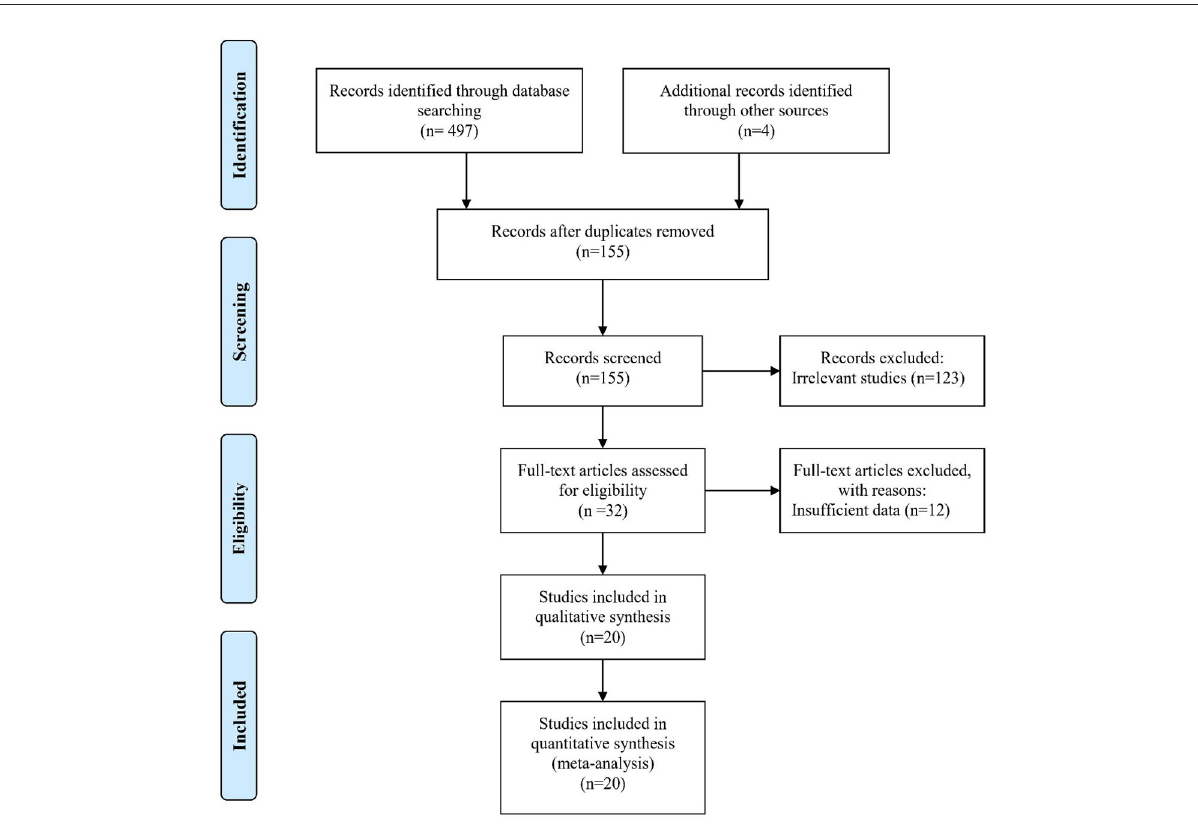
FIGURE3 PRISMA 2019 flow diagram. Publication